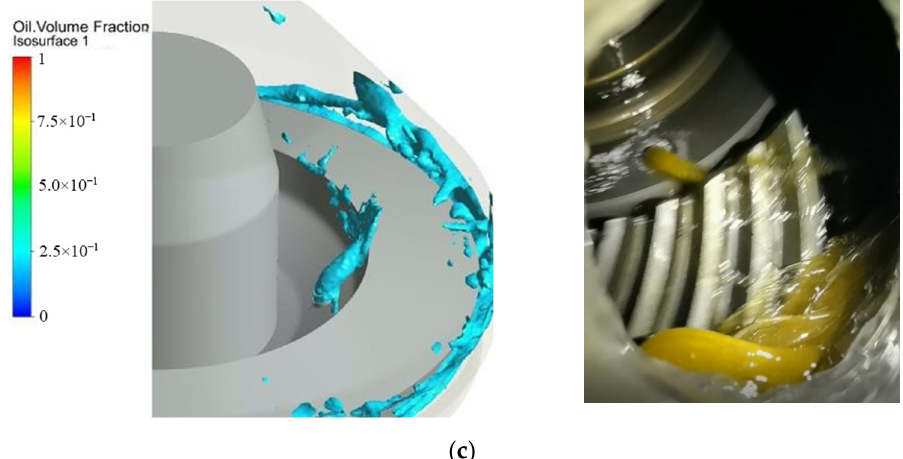
Figure 6. Comparison of test results and simulation results: ( a ) H = 40 mm; ( b ) H = 45 mm; ( c ) H = 50 mm.